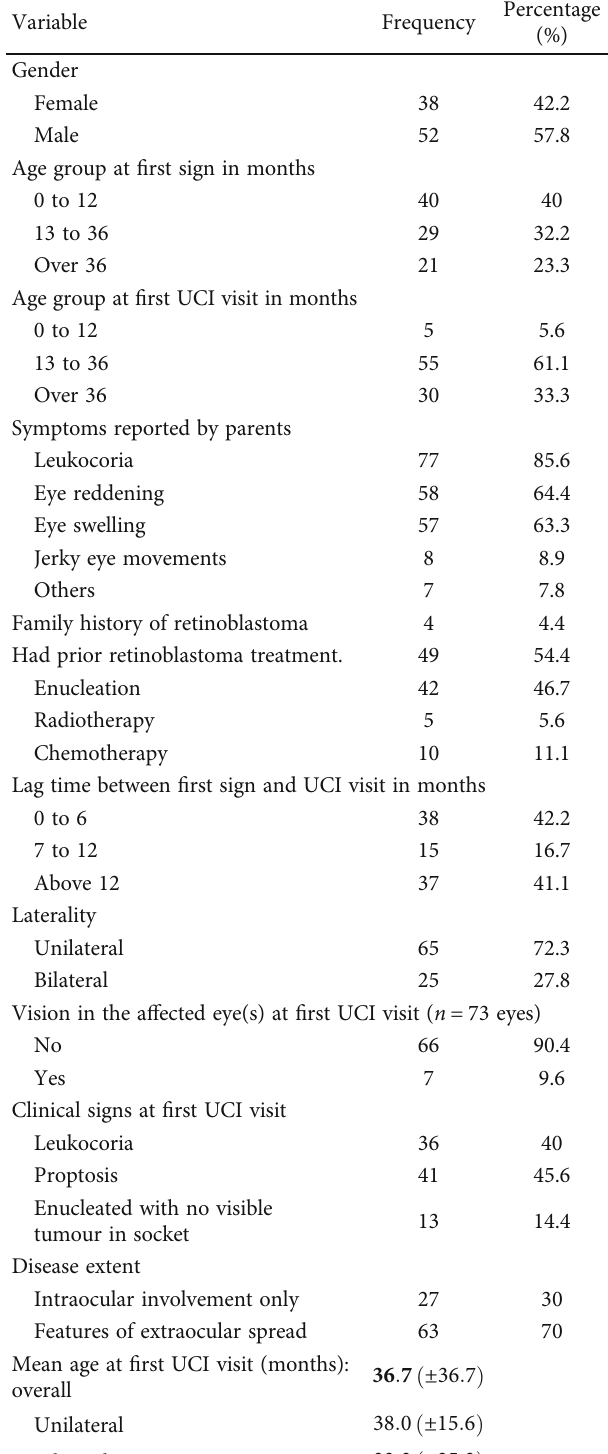
Table 1: Social demographic and clinical